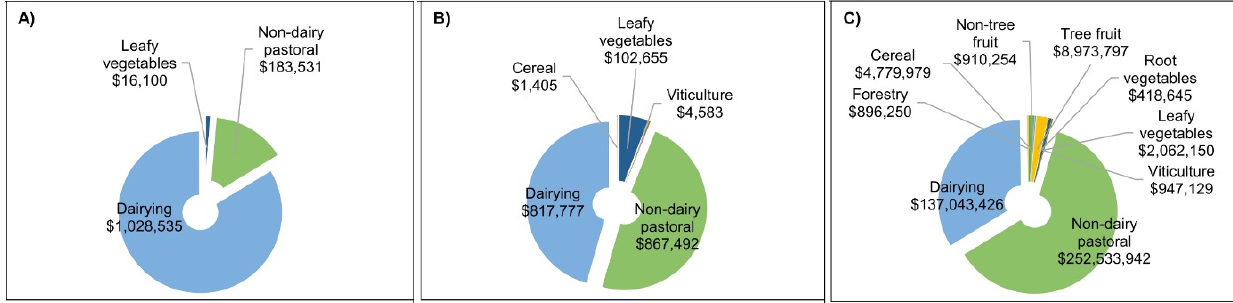
Figure 10: Financial losses (in NZ$) for the first year due to tephra fall from an [A] October 1995 Ruapehu eruption; [B] June 1996 Ruapehu eruption; and [C] ∼ 1314 CE Kaharoa eruption. See Supplementary Material 4 for production values applied and losses per